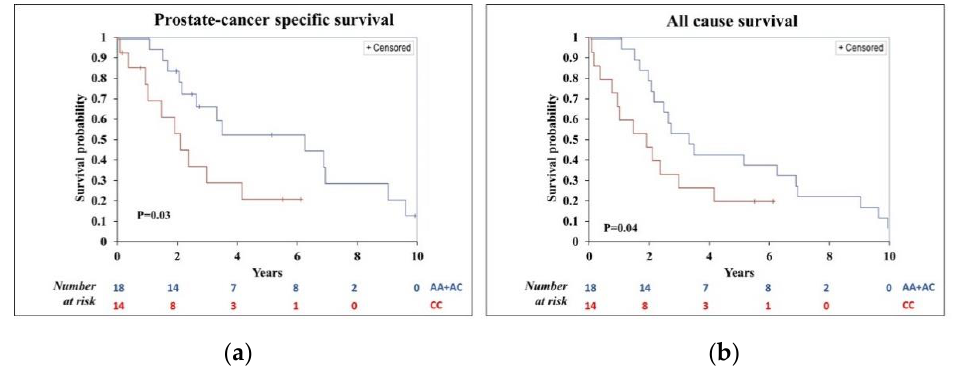
Figure 1. Prostate cancer (PC)-specific and all-cause survival for CC/CA vs. AA genotype in HSD3B1 rs1047303 in men diagnosed with stage 4, metastatic PC. ( a ) PC-specific survival; ( b ) All-cause survival.